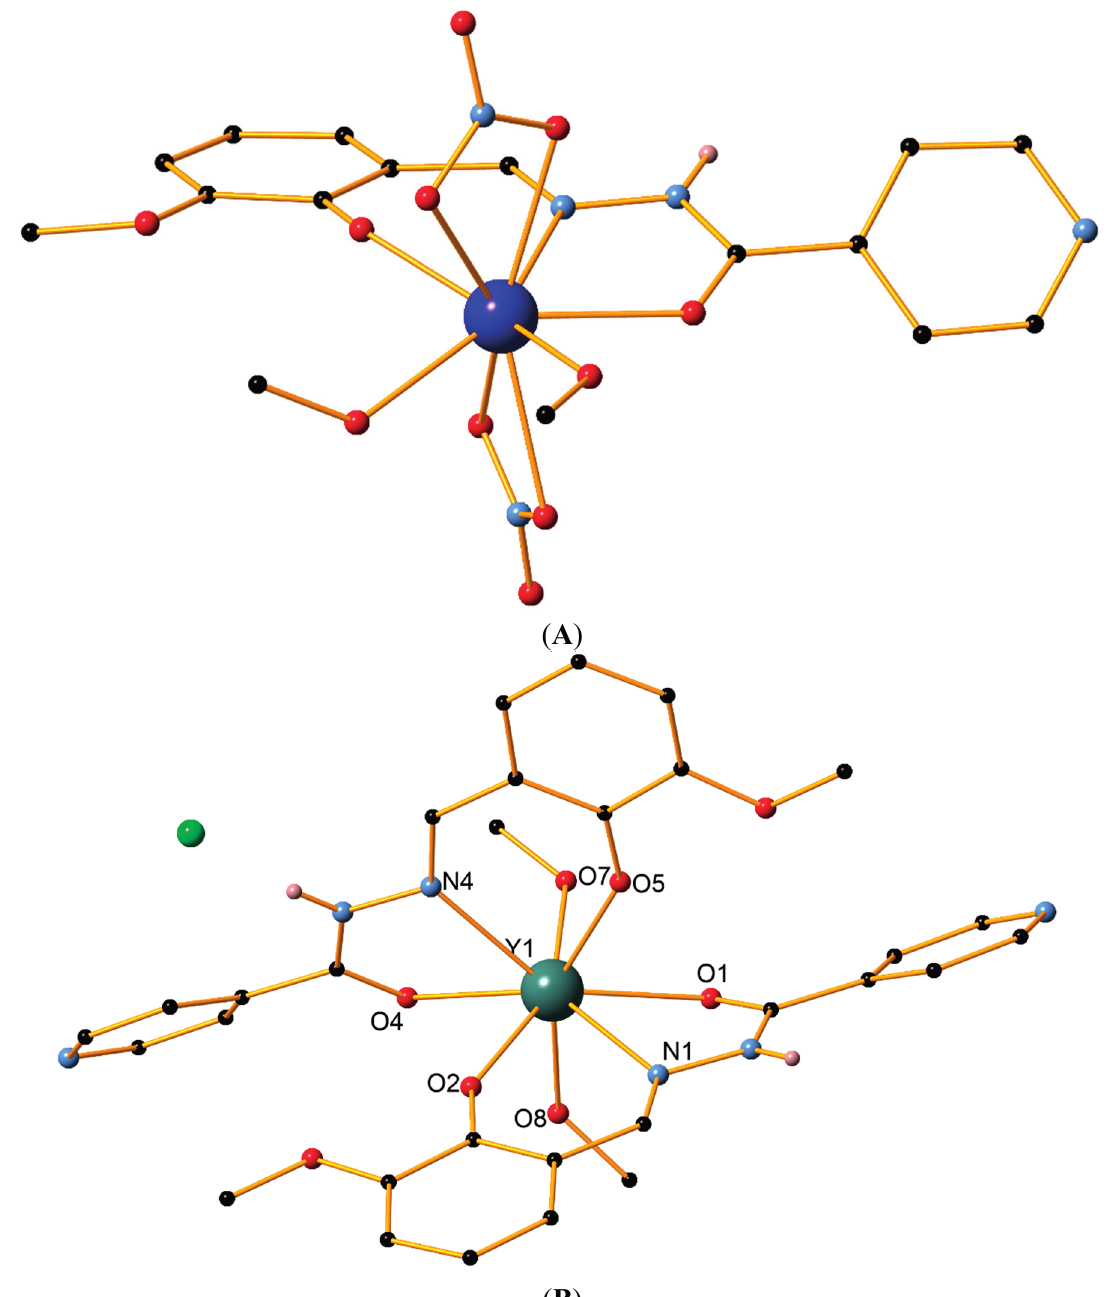
Figure 3. ( A ) The structure of the 3-Dy monomer; ( B ) The structure of compound 4-Y . Certain H atoms and all lattice solvent molecules are omitted for clarity. Colour code Dy (purple), Y (dark green), Cl (green), C (black), N (light blue), O